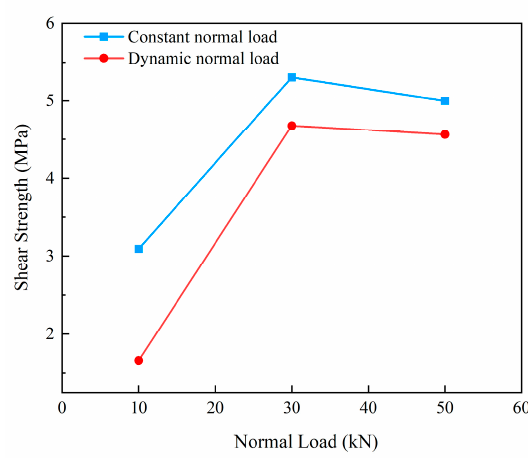
Figure 6. Relationship between normal load and shear strength.